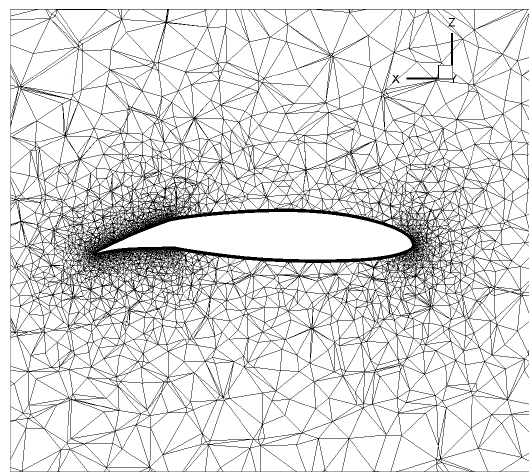
Figure 9. Plan view of the volume mesh at half-span section of the right